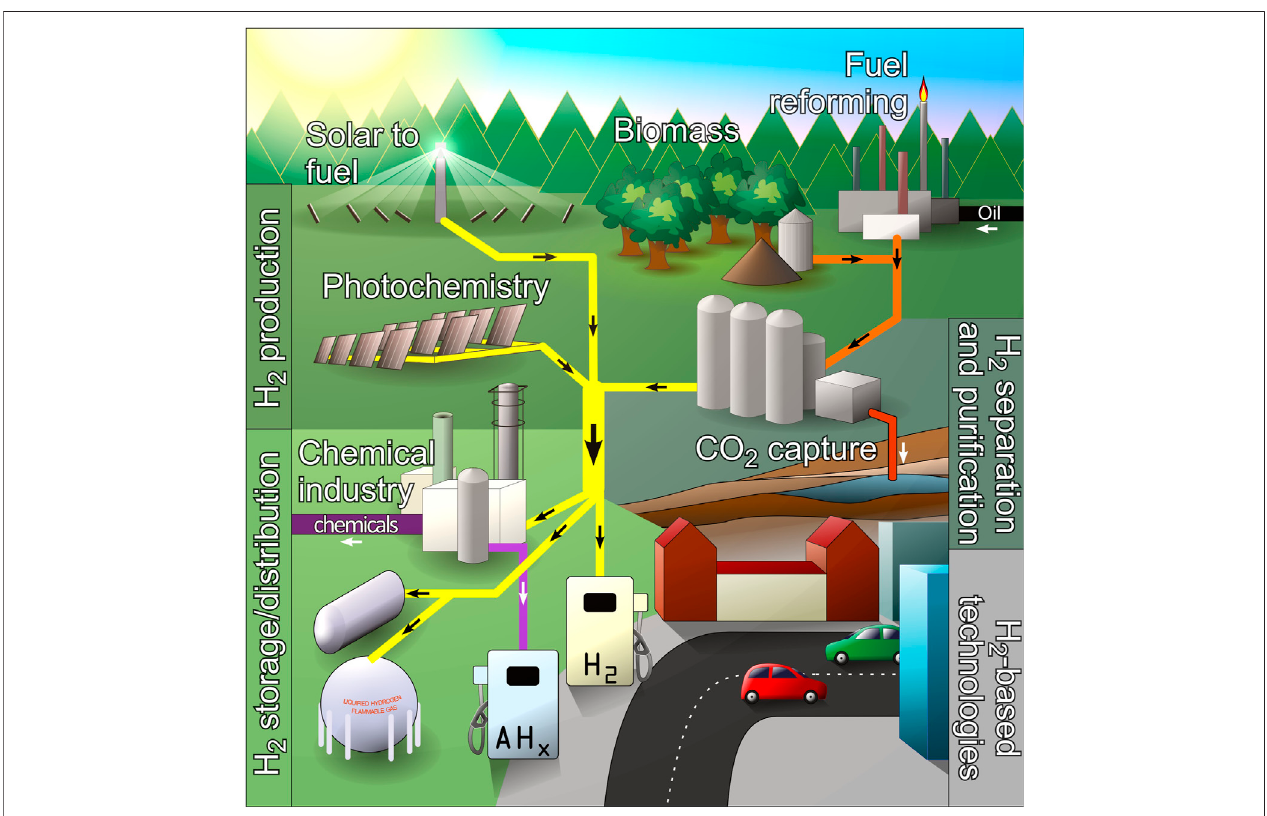
FIGURE 1 | Schematic of an integrated low-carbon economy using various hydrogen technologies, including production, storage/distribution, separation/ puri fi cation, and utilization. The fl owsof energy or species areshown incolor: fossilfuels(black), electricity (yellow), reforming and gasi fi cation products (orange), carbon dioxide (red), and chemicals and hydrogen carriers